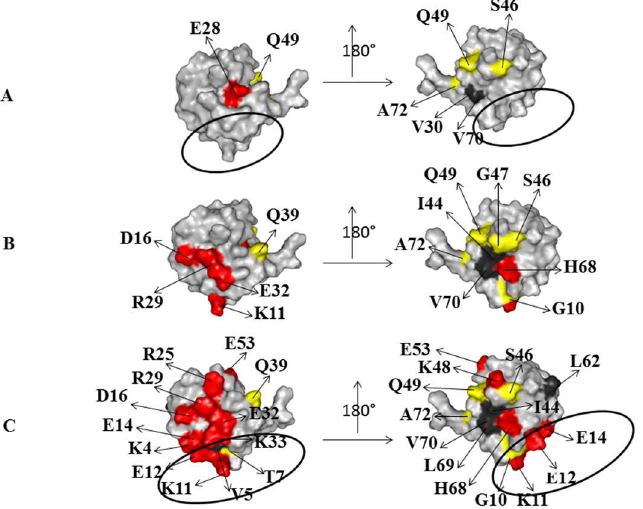
Figure 7. Molecular surface regions of 15 N labeled NEDD8 that are perturbed upon the interaction with CUBAN, at the molar ratios CUBAN:NEDD8 of: 5:1 ( A ); 2:1 ( B ); and 1:1 ( C ). Color code is the same as in Figure 6. Black circles define the surface region of the interaction with NEDD8 found in the CUBAN/NEDD8 complex [14].